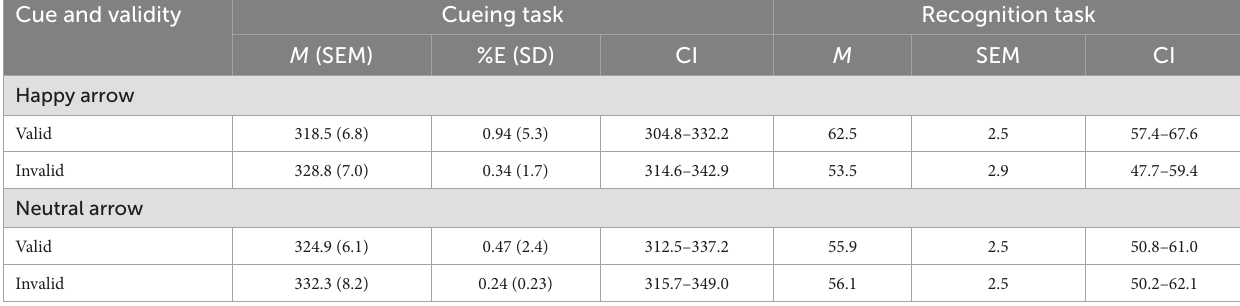
TABLE 2 Mean response times (ms) in the cueing task and mean accuracy (%) in the recognition task as a function of cue and validity in Experiment 2A. Cue and